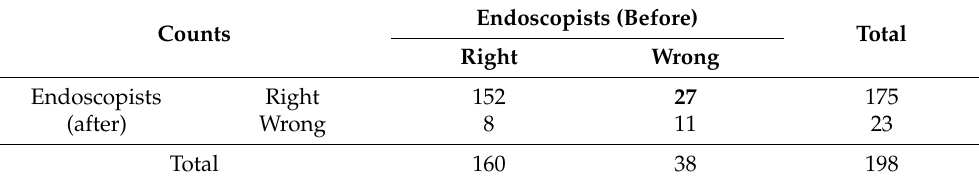
Table 5. The diagnosis results of the endoscopists after referring to the results of the proposed model.